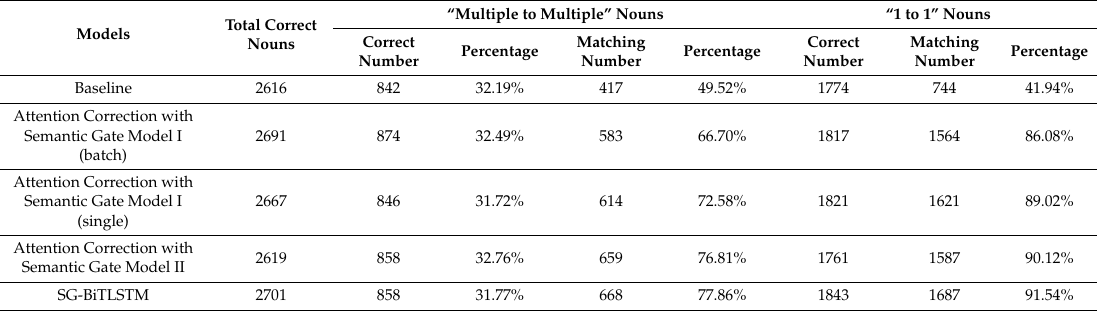
Table 7. Result of location analysis of “Multiple to Multiple” and ”1 to 1”